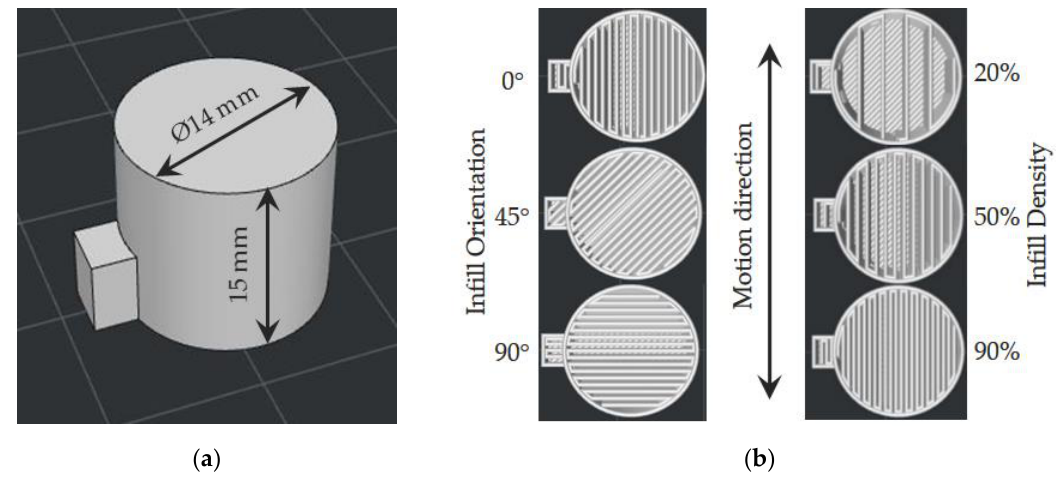
Figure 1. Specimen design ( a ); visualisation of the infill orientation and infill density ( b ).